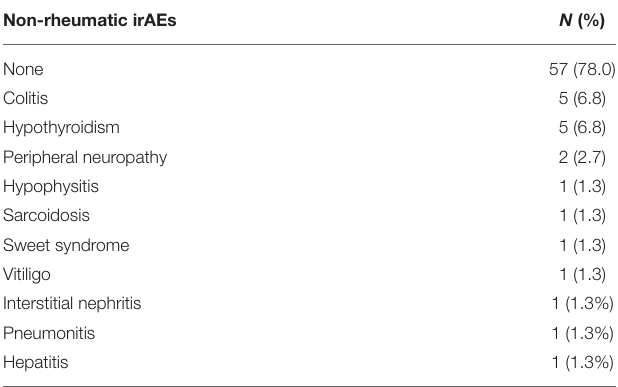
TABLE 2 | Main irAEs non rheumatic features.